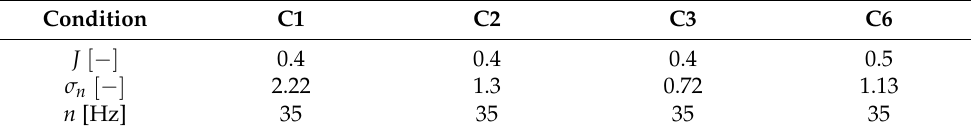
Table 2. Newcastle test case. Considered test conditions for the round robin test.